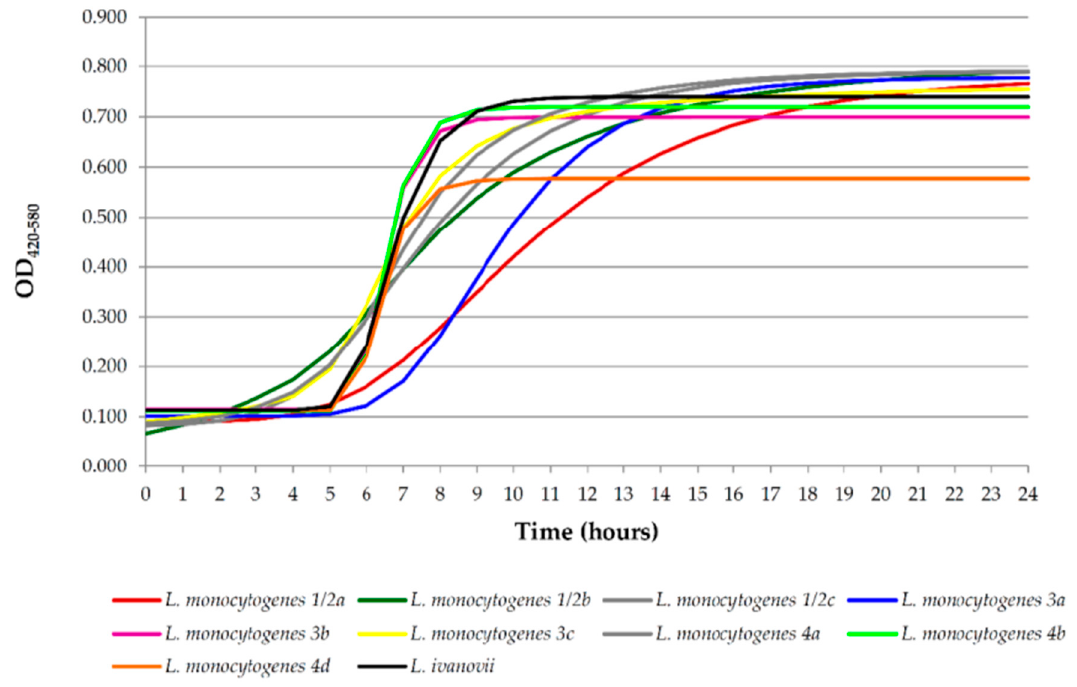
Figure 3. Growth curves (optical density at 420–580 nm) in tryptone soya broth for Listeria ivanovii and various serotypes of Listeria monocytogenes incubated for 24 h at 37 °C. Table 1. Microbial growth parameters recorded for ten strains of Listeria spp. incubated in tryptone soy broth for 24 h at 37 °C.